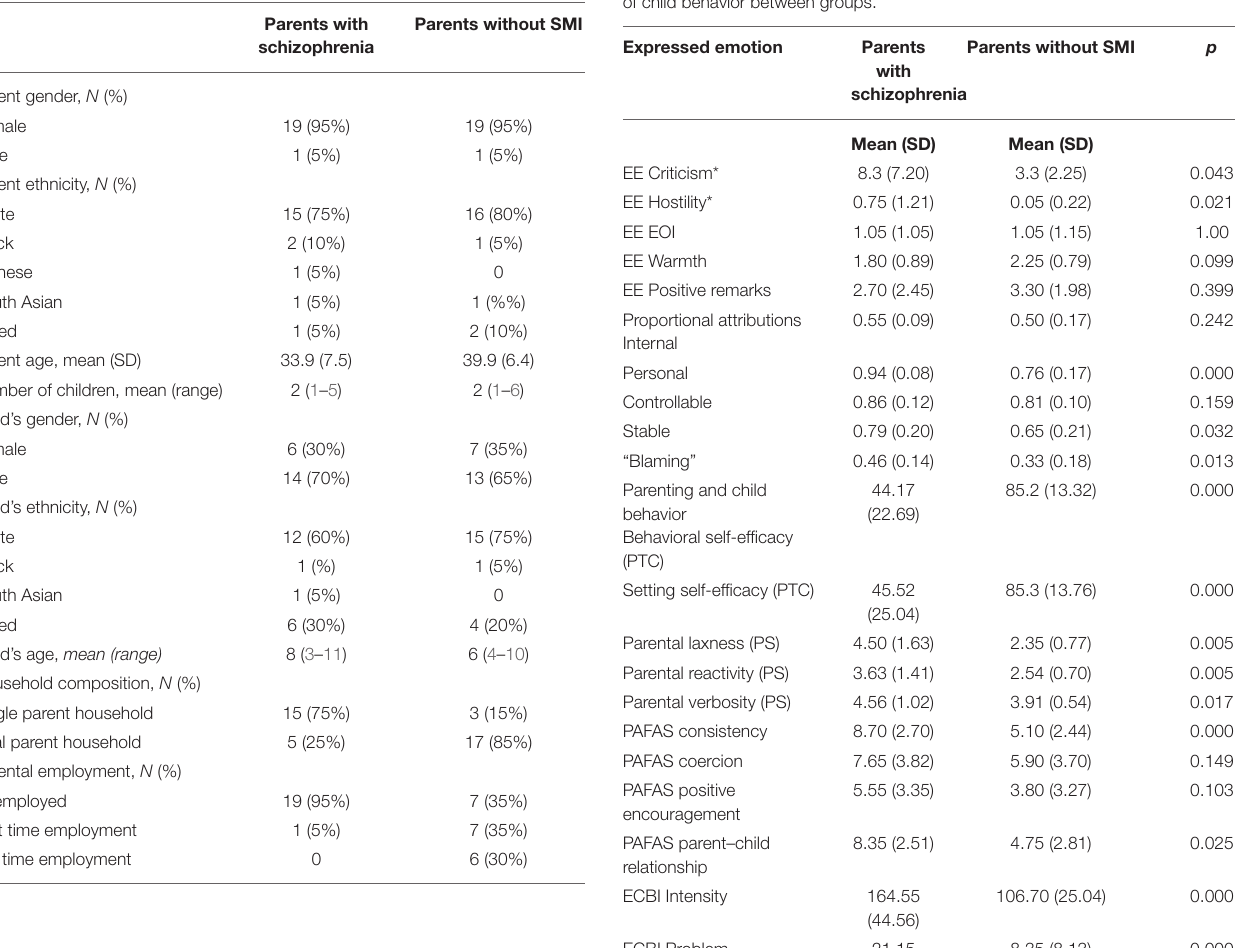
TABLE 2 | Participant characteristics.